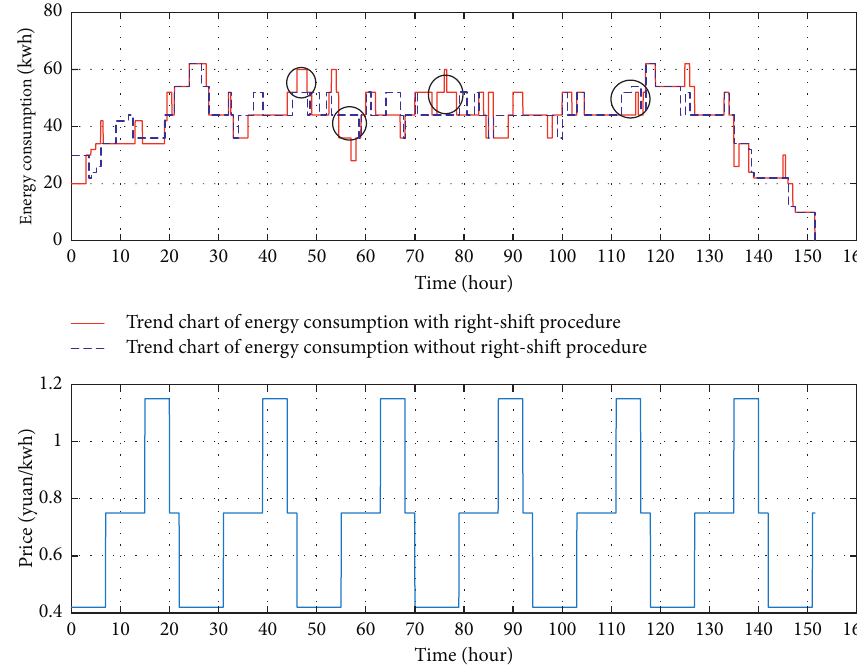
Figure 14: Trend charts of real-time total energy consumption of all machines.